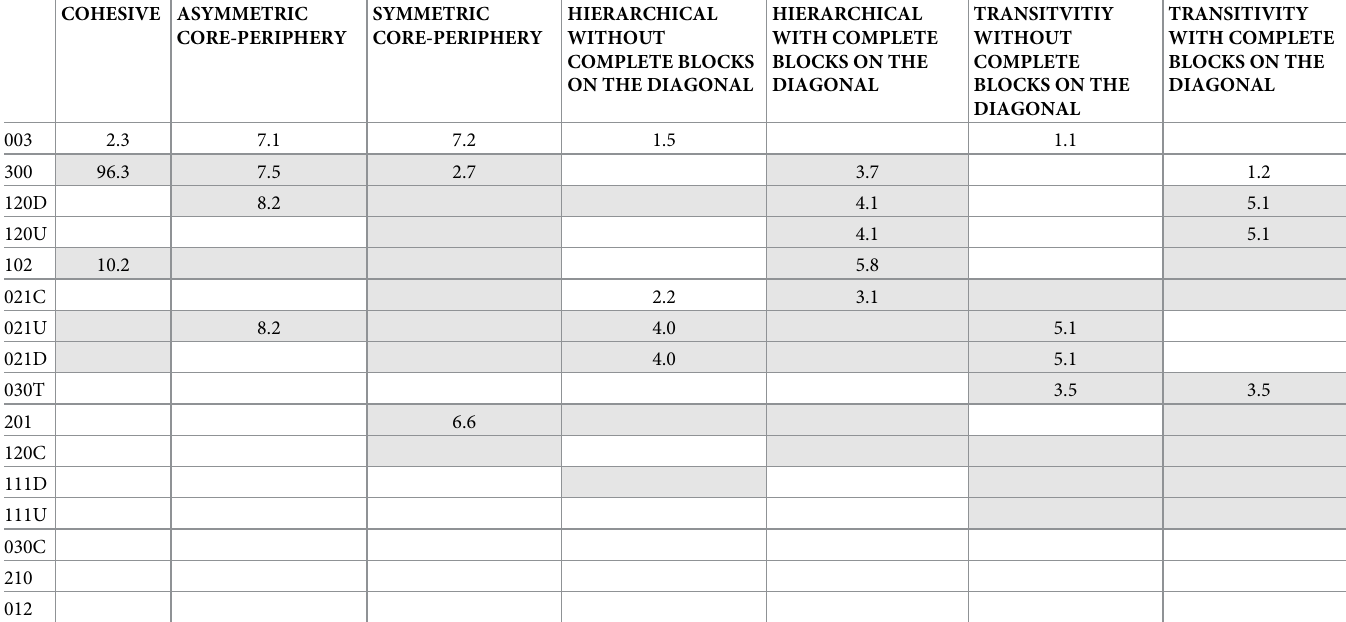
Table 1. A-measure values and the classification of allowed and forbidden triad types, and selected allowed and forbidden triad types for different types of blockmo- dels. Values greater than zero denote allowed types of triads while the values which equals zero (cells without numbers) denotes forbidden types of triads; grey color denotes selected triad